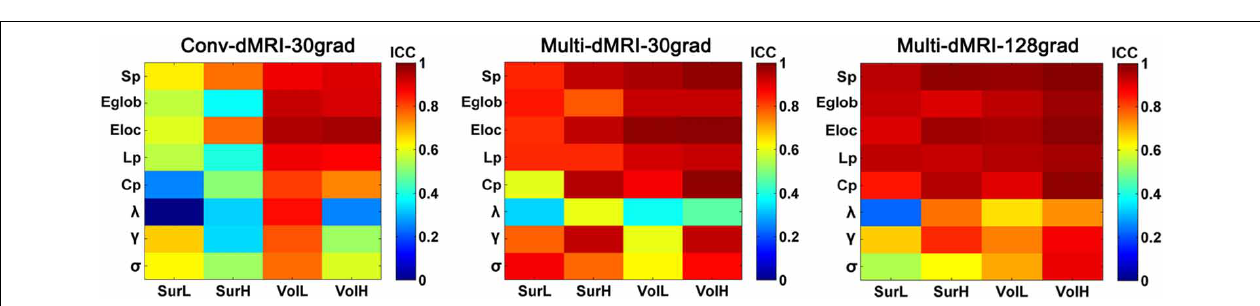
FIGURE 10 | The TRT reliability from conventional dMRI and subsampled multiband dMRI dataset. The ICC values of global network metrics from low to high were presented with colorbars from blue to red. The results showed a